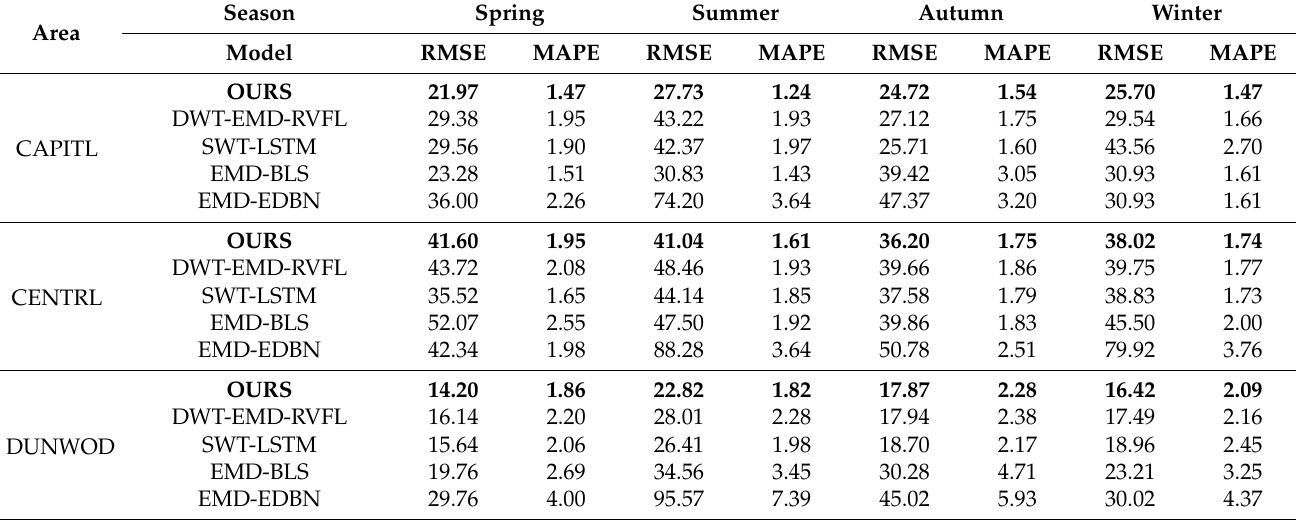
Table 4. The error of comparison with other hybrid